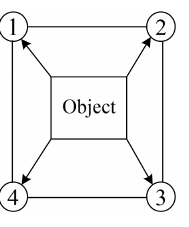
Figure 2. Communication topology. Table 1. Properties of towlines [15].